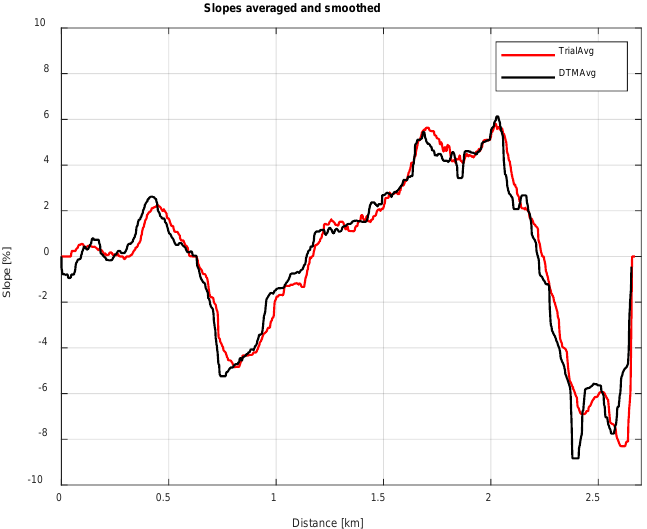
Figure 20. Smoothed slopes from trials and from geodetic data.